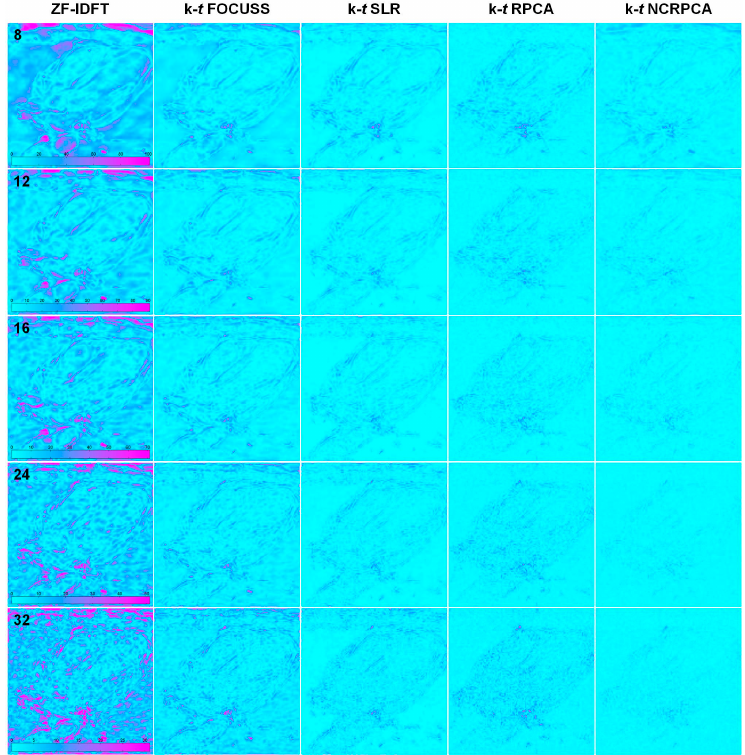
Figure 6. Qualitative results for in vivo coronal cardiac dataset with eight radial projections. From top to bottom: time-frame magnitude images, x - t temporal profiles, y - t t emporal profiles, and 1D profiles (according to the point A on the reference image). (The images are best viewed in full-screen mode.)